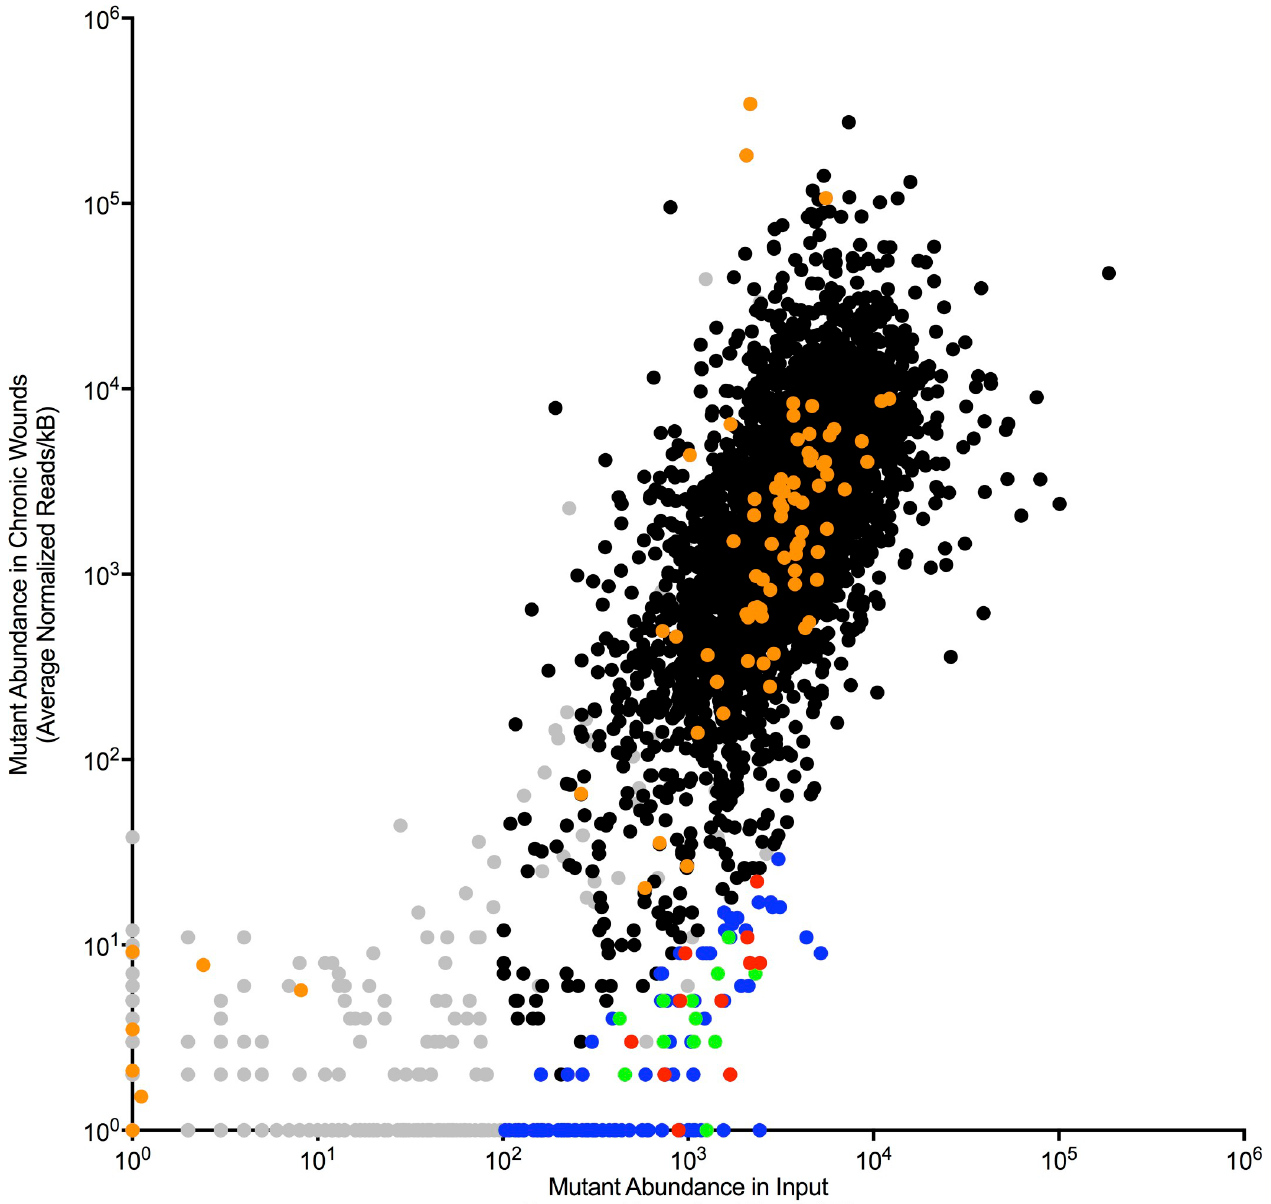
Fig 3. Identification of gene inactivations that compromise wound fitness. Tn-seq measured the relative change in abundance of mutants in the inoculum (x-axis) and after infection (y-axis). Each point represents a different gene inactivation. Gray points indicate gene inactivations with low input abundance; orange points indicate virulence genes [29]; blue, green and red points indicate gene inactivations exhibiting significant (P < 0.01) decreases in abundance after infection. Green and red points indicate gene inactivations tested in 1:1 experiments (see Fig 4); gene inactivations indicated by green points were verified to be wound-defective, while gene inactivations indicated by red points were not defective in verification experiments. Gene inactivations indicated by blue points were not tested in 1:1